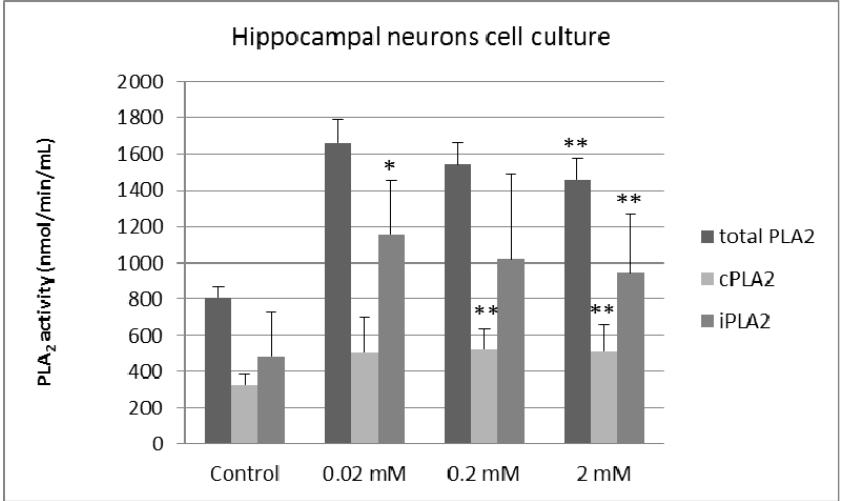
Figure 3. Effects of different concentrations of lithium chloride on the activities of total PLA 2 , cPLA 2 and iPLA 2 in cultured hippocampal neurons ( n = 5, * p < 0.05, ** p < 0.02).